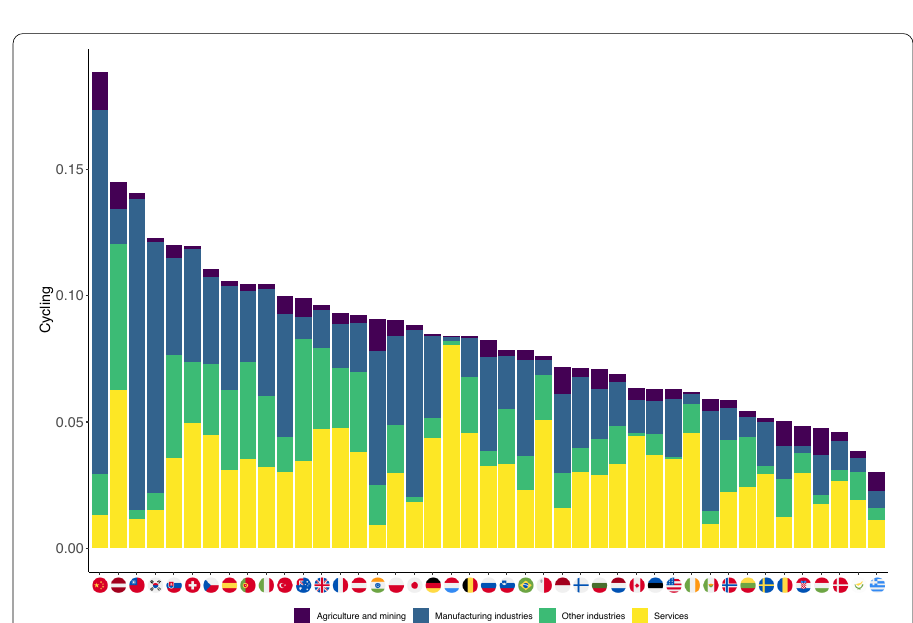
Fig. 6 The countries’ Finn cycling index in 2014. The colors represent the contribution of different types of sectors (dark magenta: agriculture and mining, blue: manufacturing industries, green: other industries, yellow: